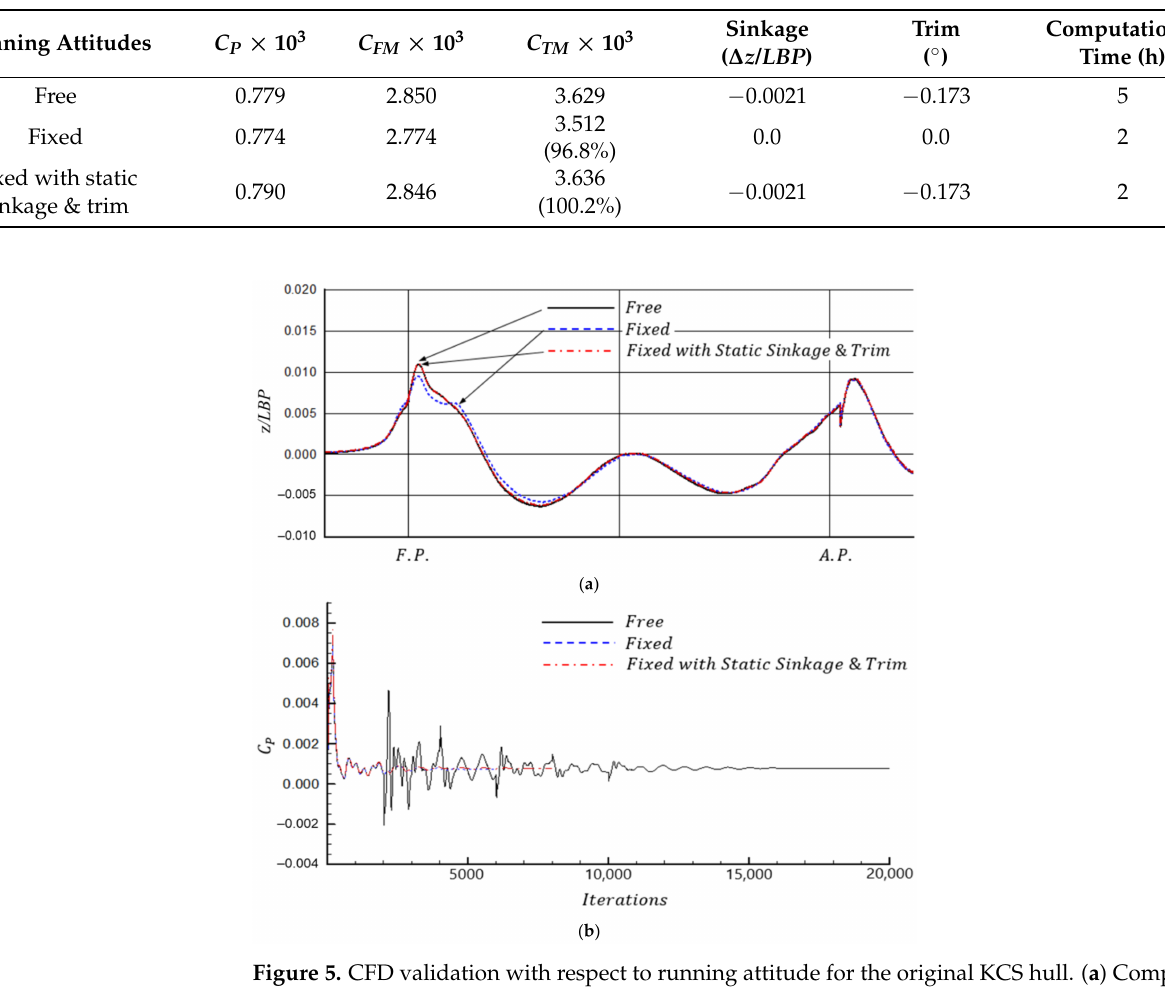
Table 4. CFD validation with respect to running attitude conditions for the original KCS hull.